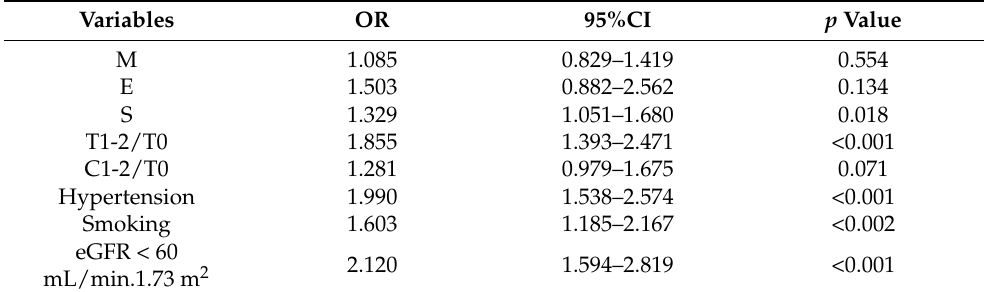
Table 3. Logistics Regression Models for the relationship between TyG index and kidney pathologic lesion and clinical